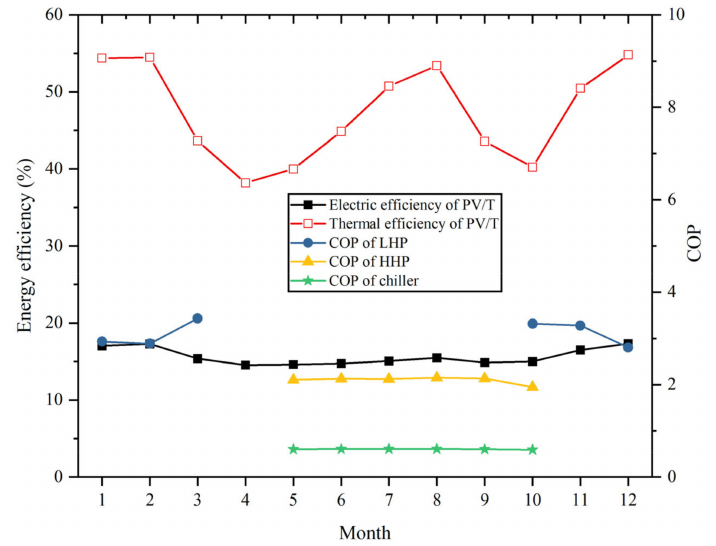
Figure 11. Monthly energy performance of equipment.